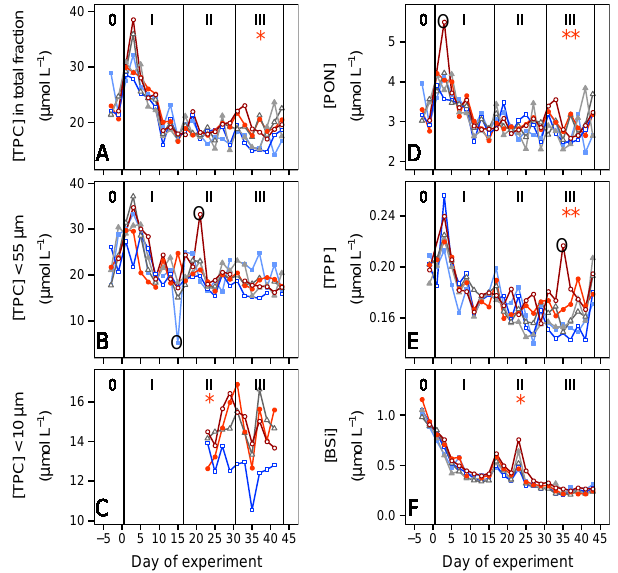
Figure 12. Temporal dynamics in concentrations of (a) total partic- ulate carbon, (b) particulate carbon <55µm, (c) particulate carbon <10µm, (d) particulate organic nitrogen, (e) total particulate phos- phorus, and (f) particulate biogenic silica. Colours and symbols are described in Table 1. Red asterisks denote significant positive ef- fect of CO 2 (* = p <0.05, ** = p <0.01). Outliers (Grubb’s test; see methods) are indicated by black circles and were excluded from linear regression analyses.